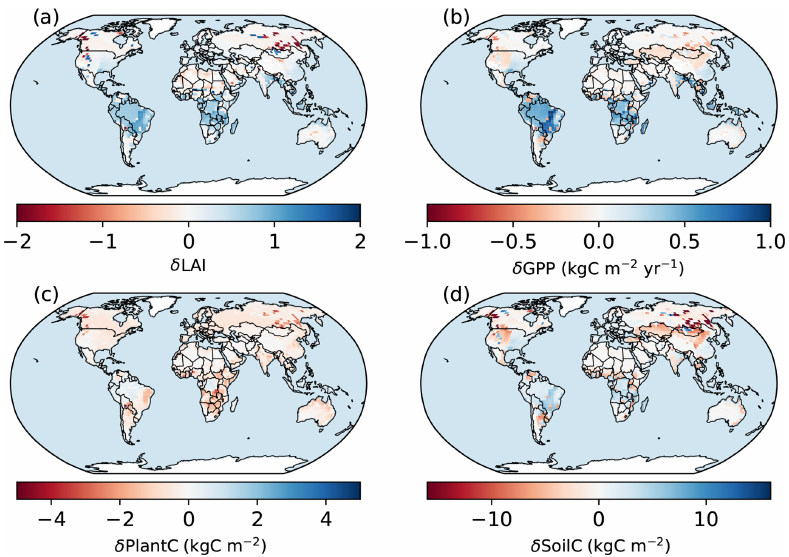
Figure 12. Spatial patterns of the differences between the simulations of the BiomeE. δ means the difference between the simulations of the full demography and the single-cohort models. LAI is the leaf area index, GPP is the gross primary production (kgCm − 2 yr − 1 ), plant C is the vegetation biomass (kgCm − 2 ), and soil C is the soil organic matter (kgCm − 2 ).